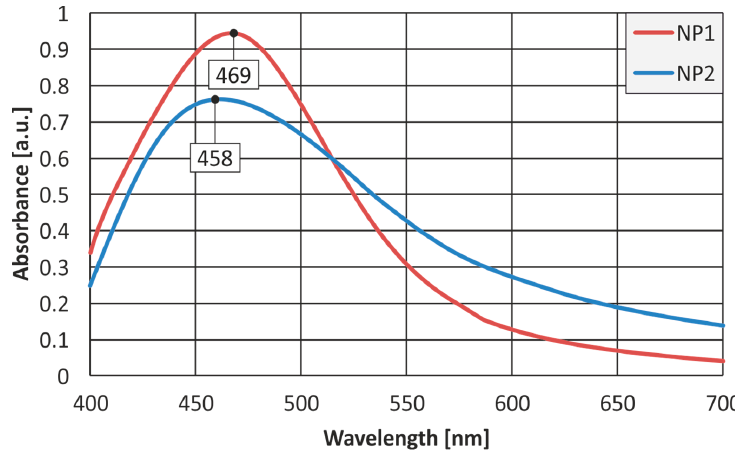
Figure 1. UV-Vis spectrometry results for both silver nanoparticles (AgNPs) variations silver nanoparticles variation 1 (NP1) and silver nanoparticles variation 1 (NP2).